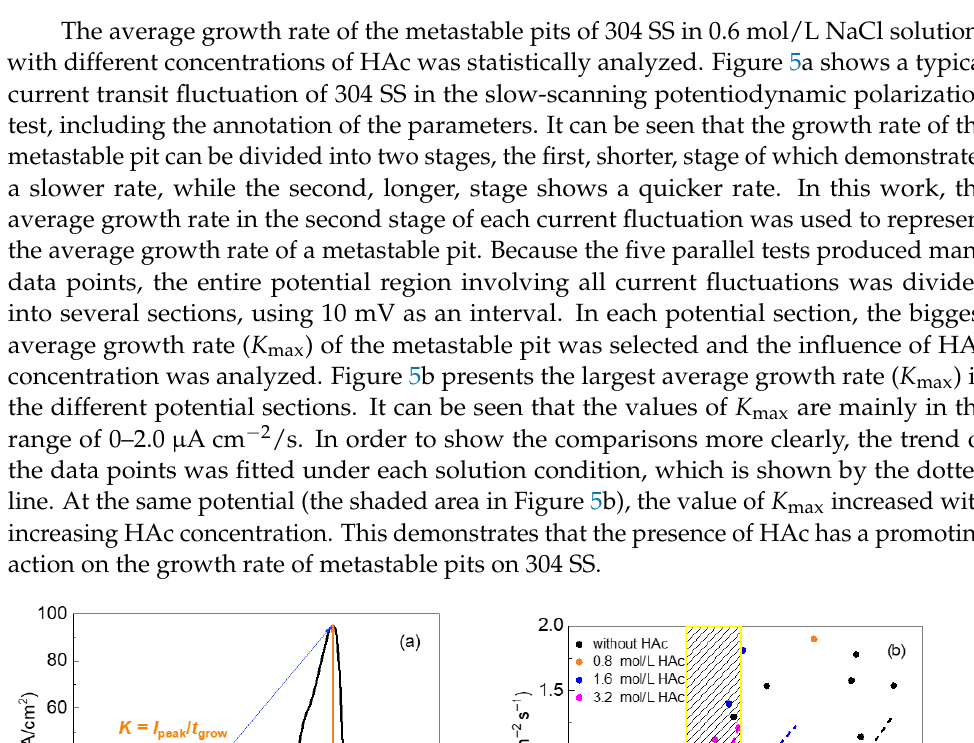
Figure 5. Typical current fluctuation of 304 SS in 0.6 mol/L NaCl solution, using a potentiodynamic polarization test ( a ) and average growth rate of metastable pits on 304 SS, in 0.6 mol/L NaCl solutions with HAc ( b